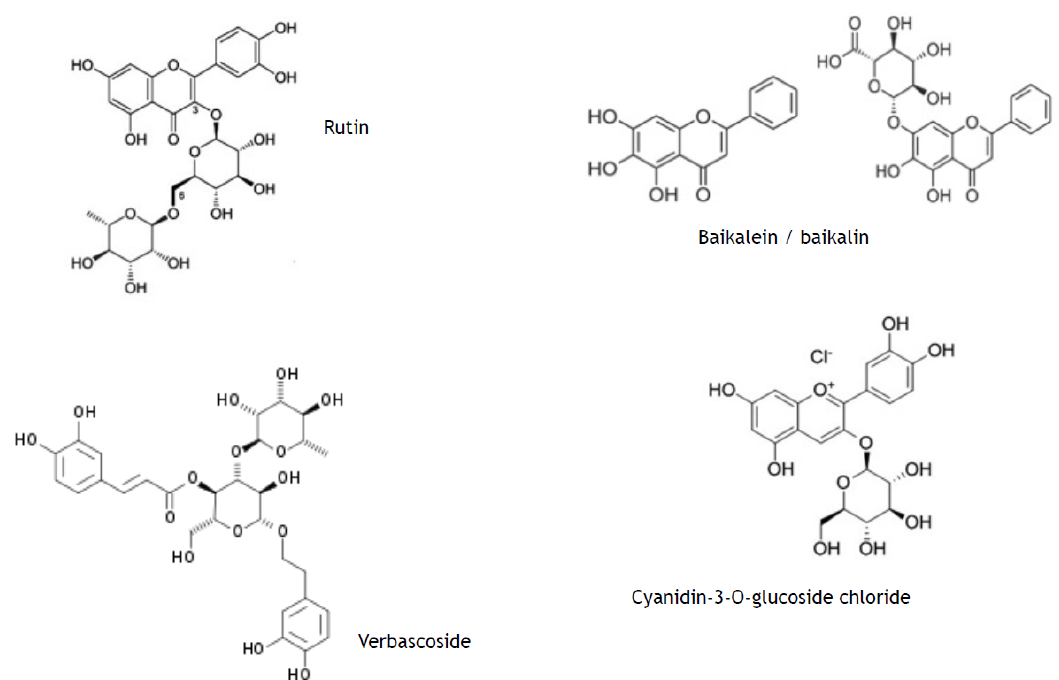
Figure 1. Photo-protective polyphenolic secondary plant metabolites. Examples of plant-derived secondary polyphenolic metabolites (phenylpropanoid glycoside verbascoside; flavonoids (glycosylated and aglycon baicalein/baicalin), rutin, silibinin).